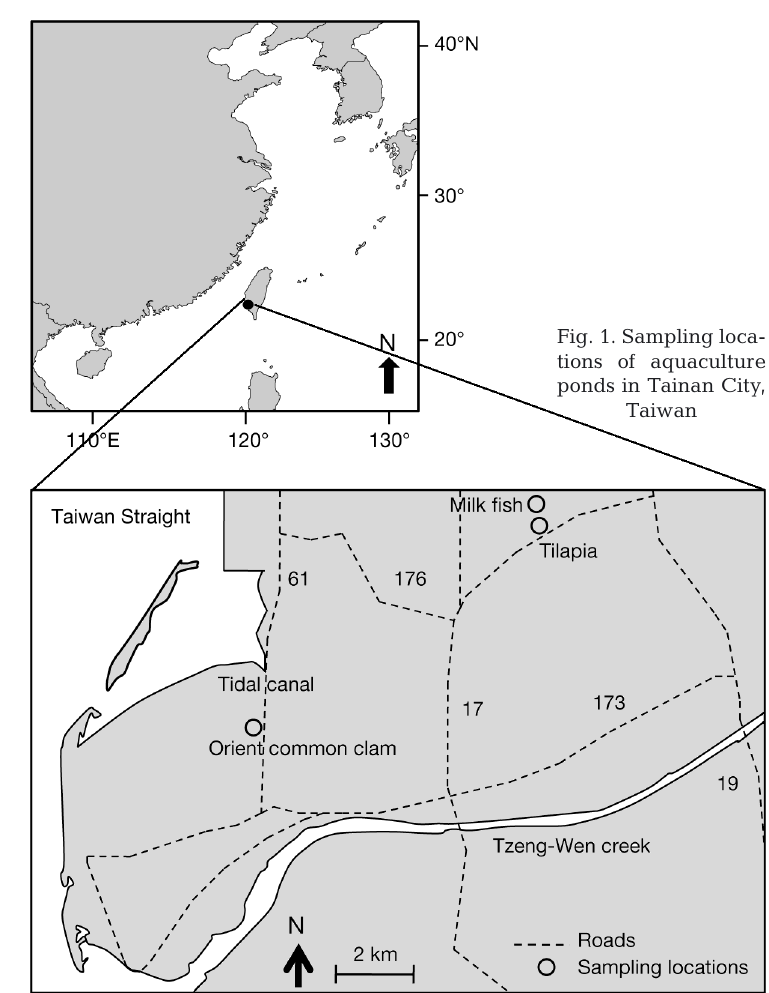
Fig. 1. Sampling loca- tions of aquaculture ponds in Tainan City,